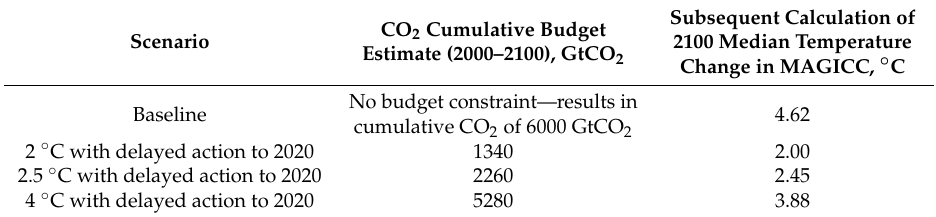
Table 1. Estimates of 2000–2100 cumulative CO 2 from fossil fuel combustion and industry sectors, with associated calculated 2100 median temperature change.